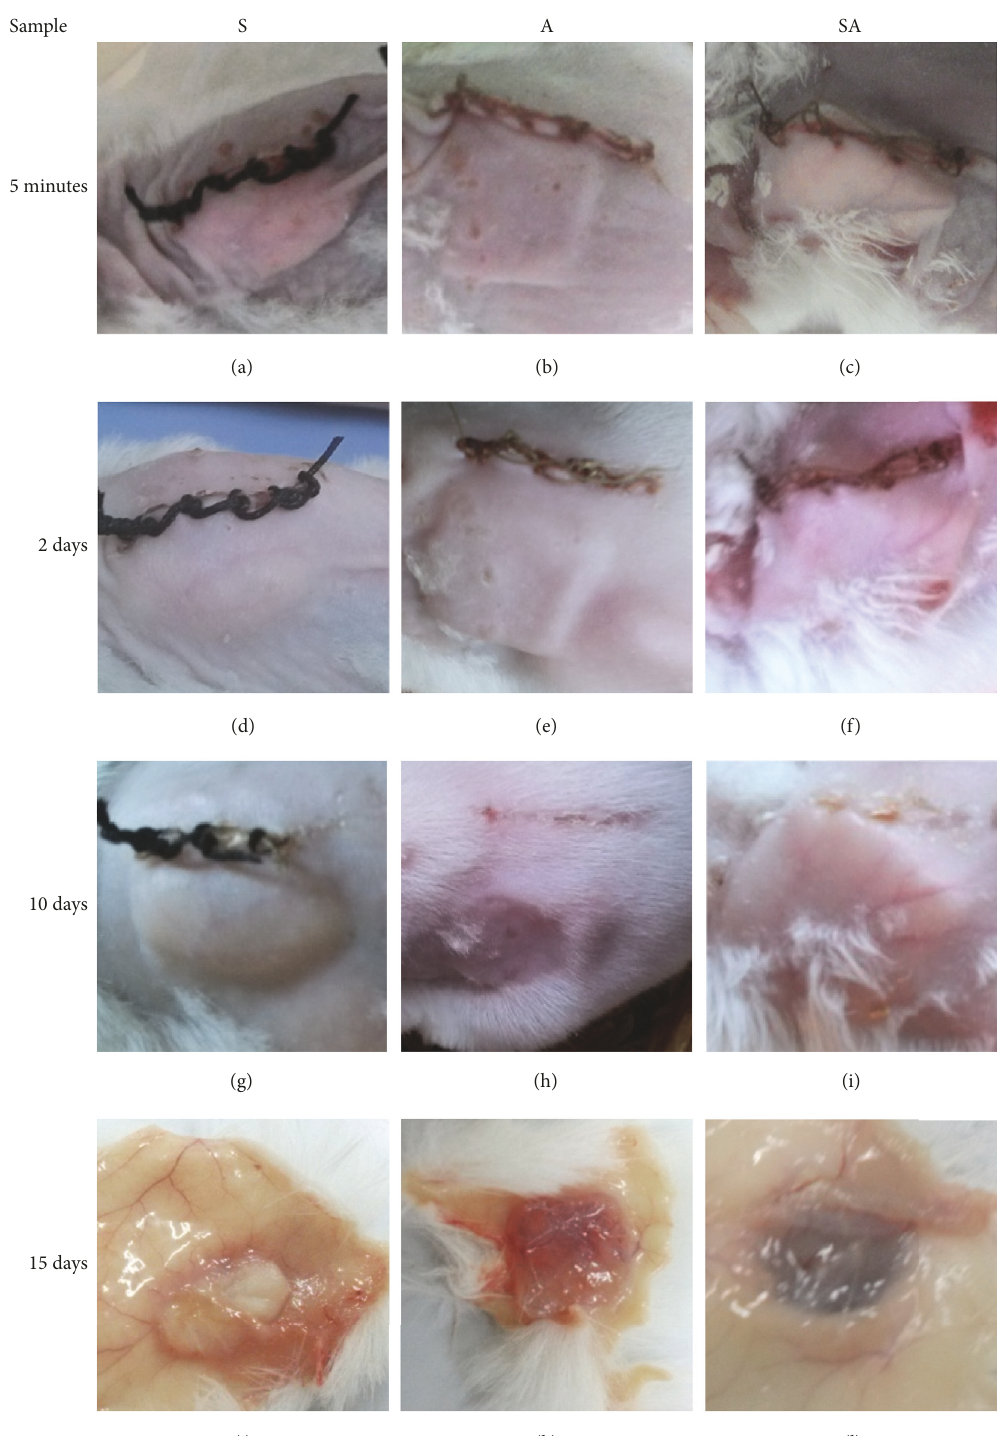
Figure 4: Subcutaneous implantation of 3 samples: (a–c) 5 minutes after implantation of S, A, and SA scaffolds, respectively; (d–f) 2 days after implantation of S, A, and SA scaffolds, respectively; (g–i) 10 days after implantation of S, A, and SA scaffolds, respectively; (j–l) extracted sample of S, A, and SA scaffolds, respectively, 15 days after